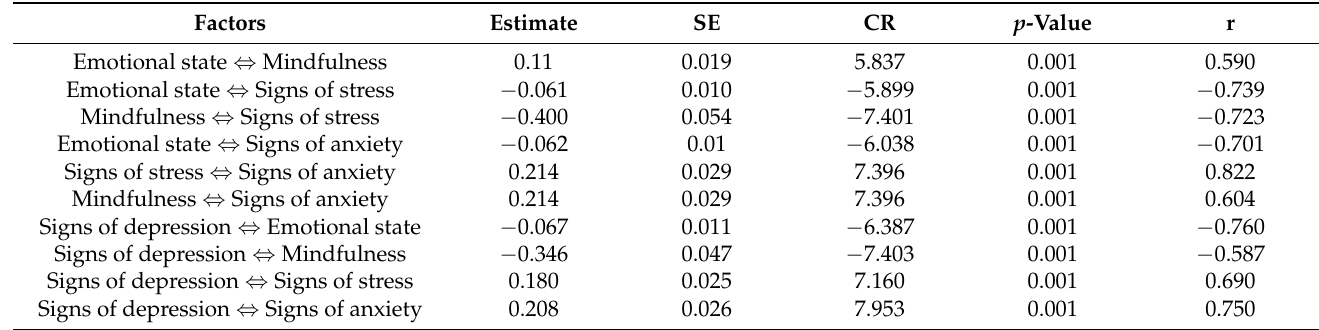
Table 4. Estimates of the latent factors (meditating athletes) in structural factor model ( N = 313), χ 2 (1604) = 2957.88, p <